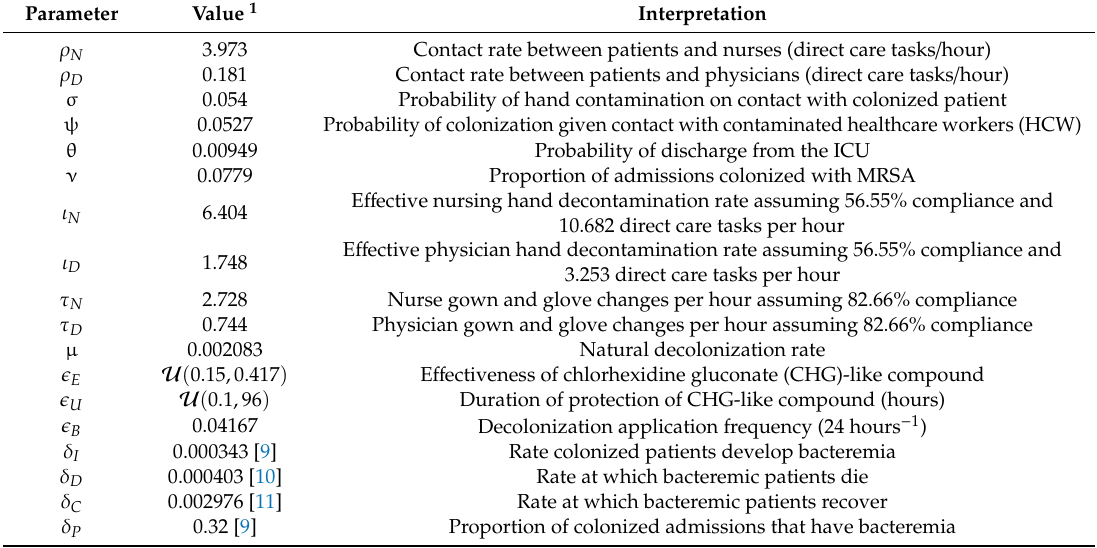
Table 1. Parameter values for a model of methicillin-resistant Staphylococcus aureus (MRSA) transmission within an